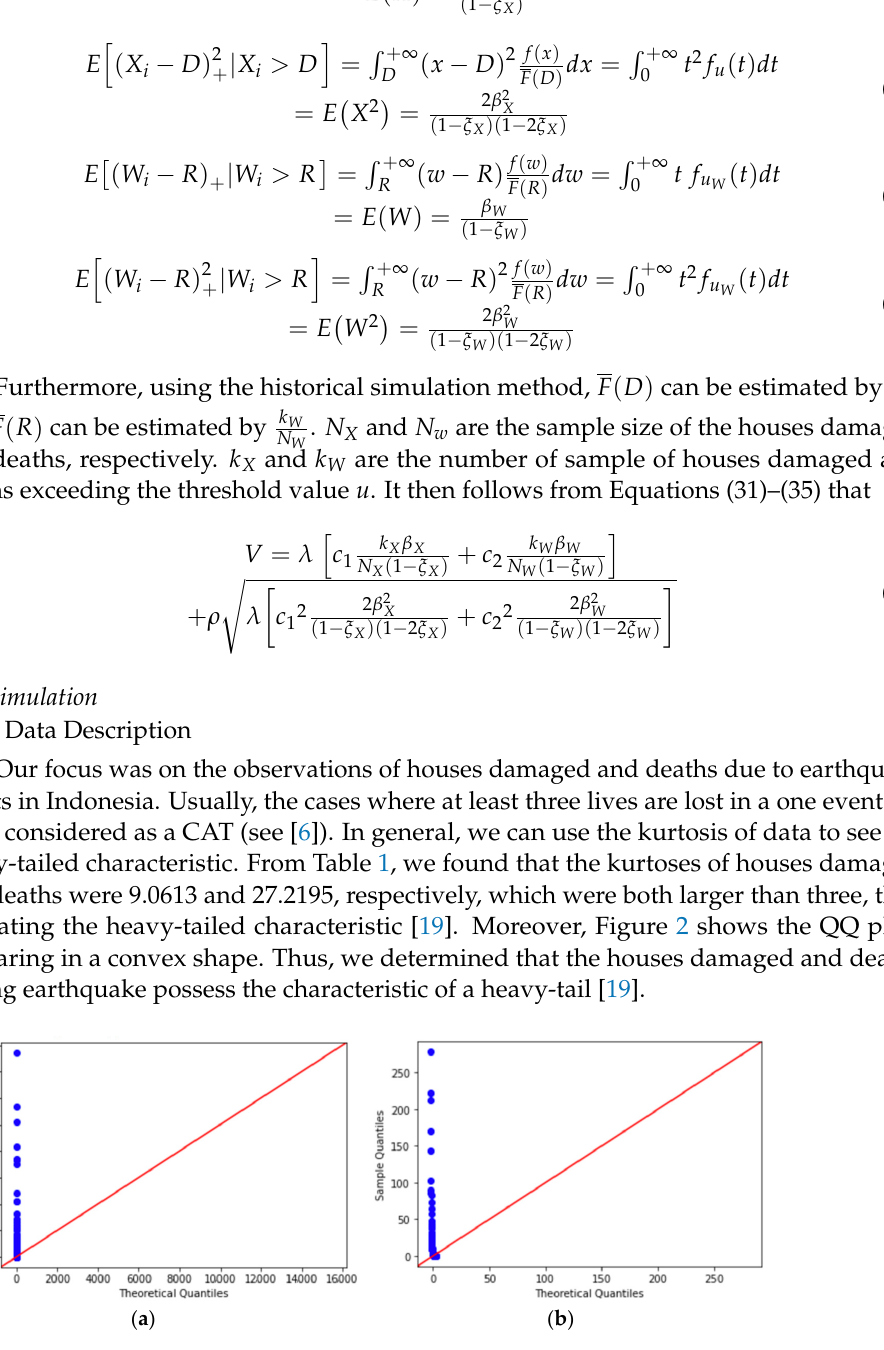
Figure 2. ( a ) QQ plot of the houses damaged and ( b )